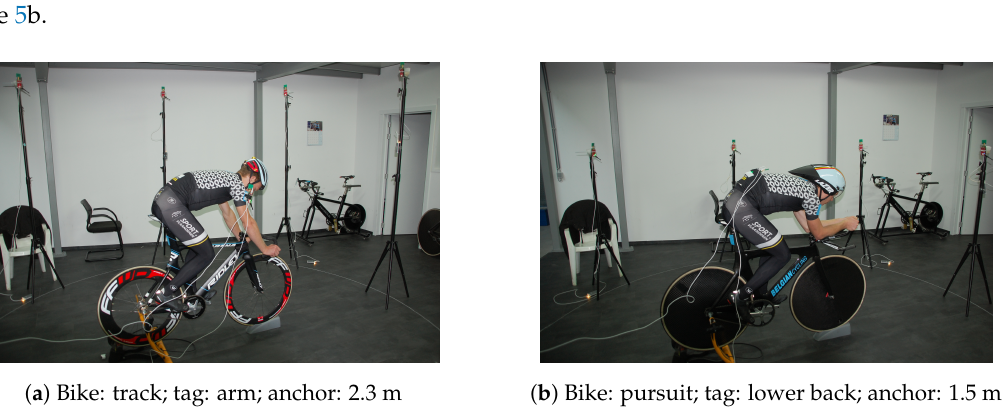
Figure 5. Static